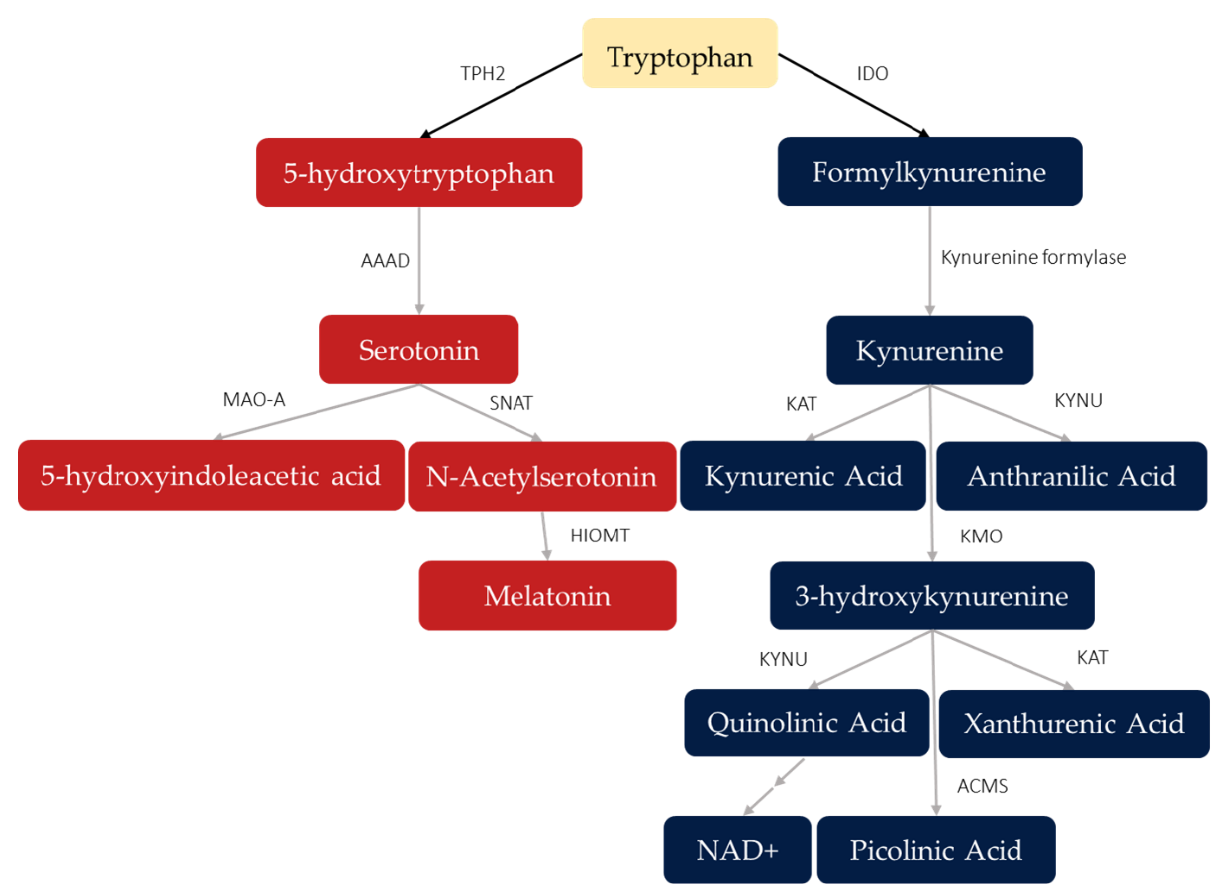
Figure 1. Products of tryptophan metabolism via serotonin (red) and kynurenine (blue) pathways. Arrows point toward the direction of metabolism as mediated by different enzymes or other catalysts, with fields showing metabolites produced along these pathways. Double arrows indicate multiple metabolic steps (catalysts not shown). Abbreviations: TPH2: tryptophan hydroxylase, isoenzyme 2; AAAD: aromatic acid decarboxylase; MAO-A: monoamine oxidase A; HIOMT: hydroxyindole O-methyl transferase; SNAT: serotonin-N-acetyltransferase; IDO: indoleamine 2,3-dioxyenase; KAT: kynurenine aminotransferase; KMO: kynurenine 3-monooxygenase; KYNU: kynurinase; ACMS: 2-amino-3-carboxymuconic-6-semialdehyde decarboxylase.